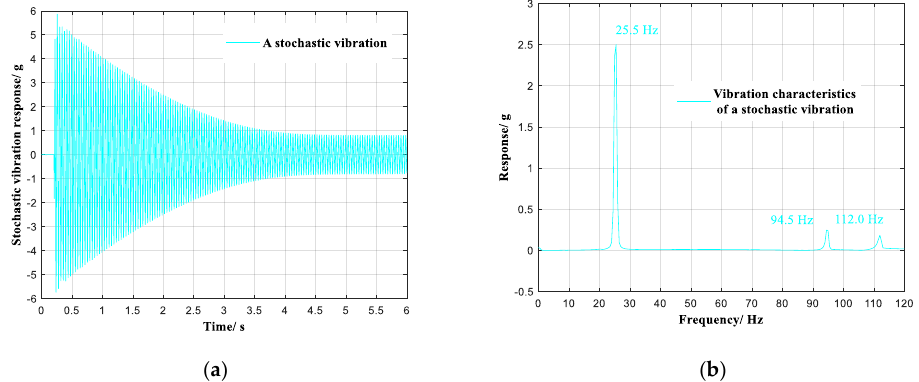
Figure 7. A selected stochastic vibration. ( a ) Response in the time domain. ( b ) Response in the frequency domain.